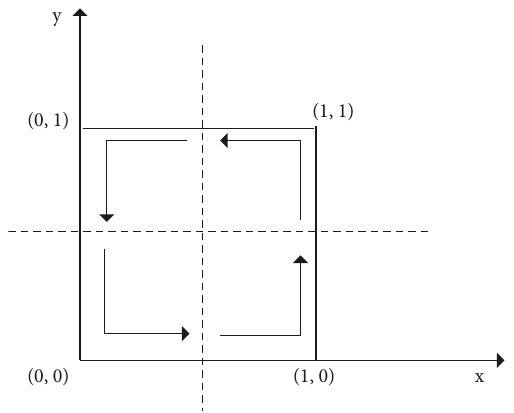
+ ω − c ) − ( π + ω − c ) > f + B E 1 E 1 E 2 E 2 1 2